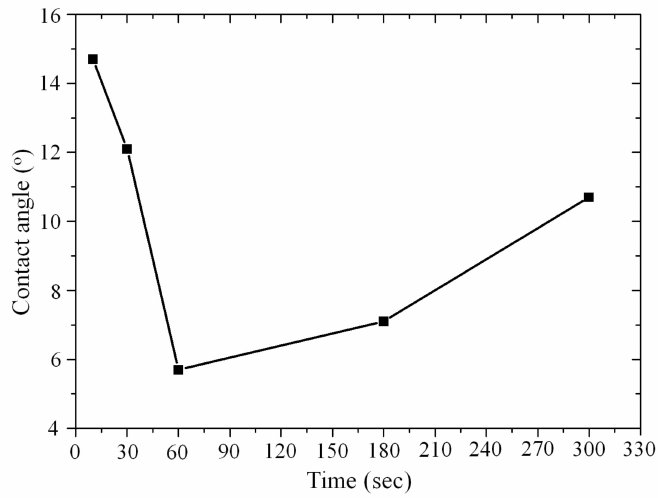
Figure 3. Contact angle versus plasma activation duration for a fixed plasma activation power of 30 W.